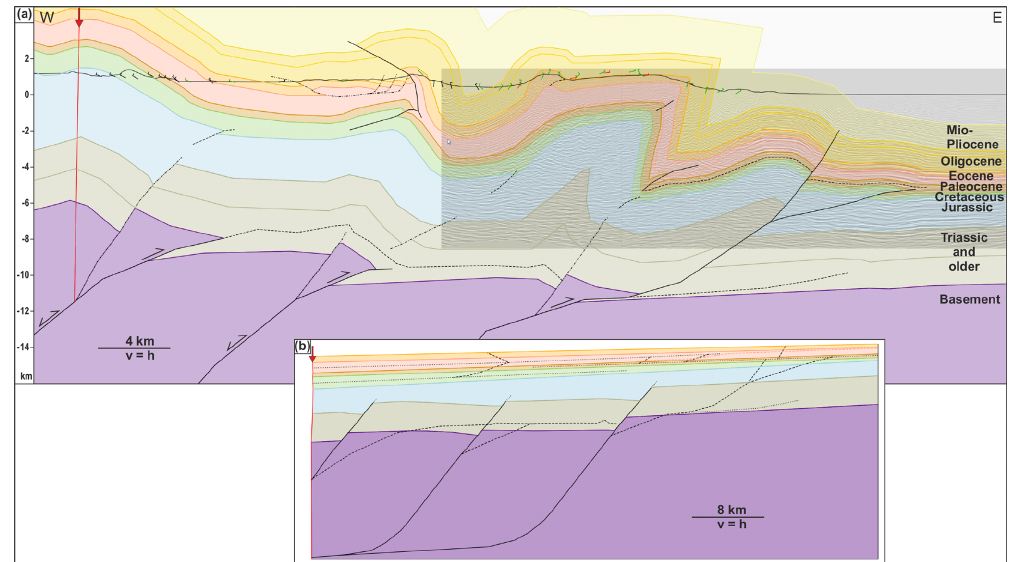
Figure 13. (a) Constructed W–E section in the northern sector of the study area with a PSDM seismic section in the background (see Fig. 9a). Dip measurements projected between 2.5 and 4km. The section is balanced between the red loose line and the eastern end of the section (fixed line). (b) Restored section (at 50% scale of a ) by using line length and area balancing methods. Calculated shortening is approximately 11.2km or